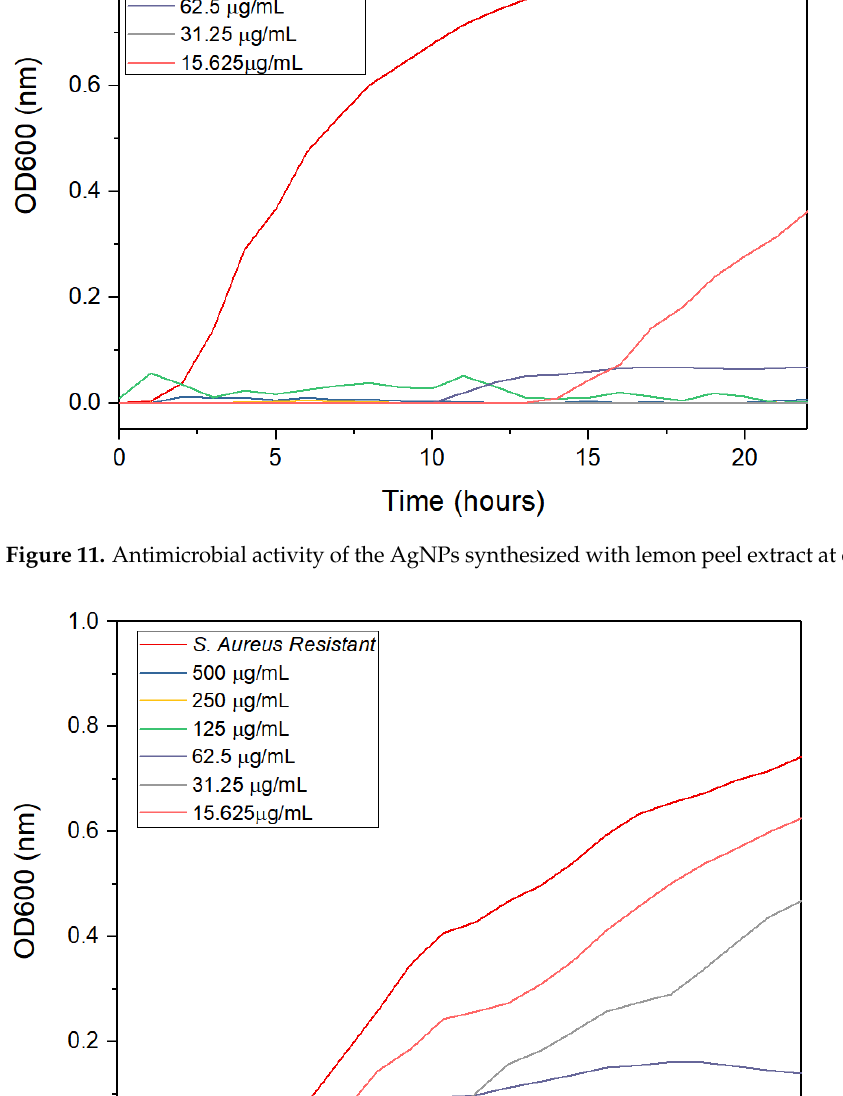
Figure 10. Antimicrobial activity of citrus peels extracts at different times. ( A ) Lemon peel extract. ( B ) Orange peel extract. ( C ) Grapefruit peel extract. ( D ) Mixture of lemon, orange, and grapefruit extracts.